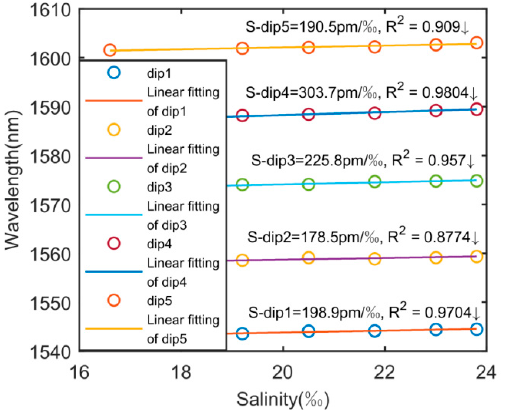
Figure 9. Relationships between the specific wavelengths and the salinities.